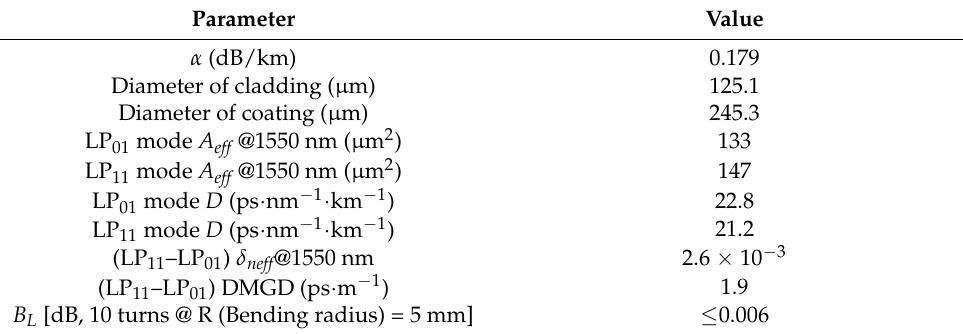
Table 1. Parameters of the MSI 2-LP-mode Fiber.